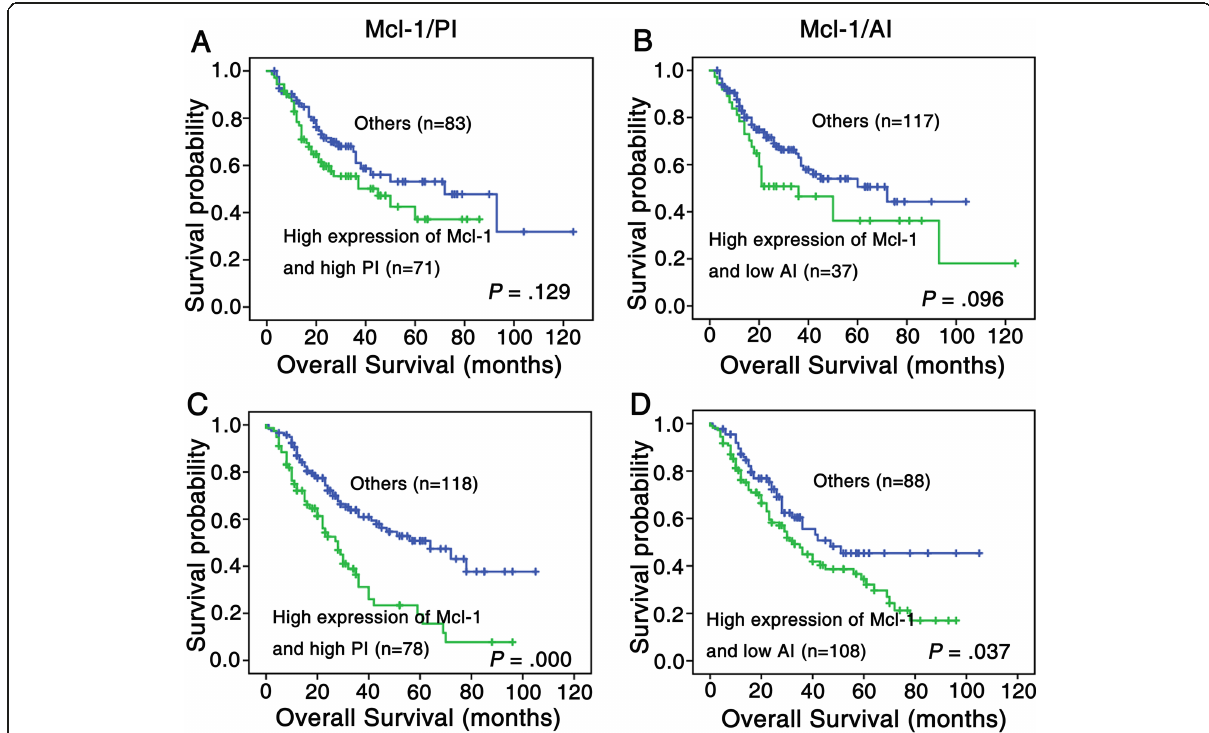
Fig. 5 Kaplan-Meier analysis was used to plot the overall survival of 154 cases of lung SCC ( a and b ) and 196 cases of lung ADC ( c and d ) patients with differential combined Mcl-1 expression, PI and AI, which statistical significance was assessed by log-rank test. ( a ) Kaplan-Meier curves showed that there was no statistical significance between lung SCC patients with combined high Mcl-1 expression and PI and that with low expression with either of two proteins mentioned above ( P > 0.05, two sided). ( b ) There was no apparent difference between lung SCC patients with combined high Mcl-1 expression and low AI and that with other expression patterns of these two proteins ( P = 0.096, two sided). ( c ) Lung ADC patients with high expression of both Mcl-1 and PI had worse overall survival rates compared with either of low expression of two proteins above ( P < 0.0001, two sided). ( d ) Lung ADC patients with high Mcl-1 expression and low AI owned poor prognosis compared with that with other expression patterns of these tow proteins ( P = 0.037, two sided)